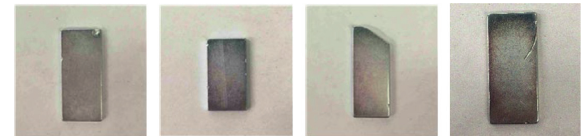
Figure 9: Common defect appearance of rare-earth magnetic